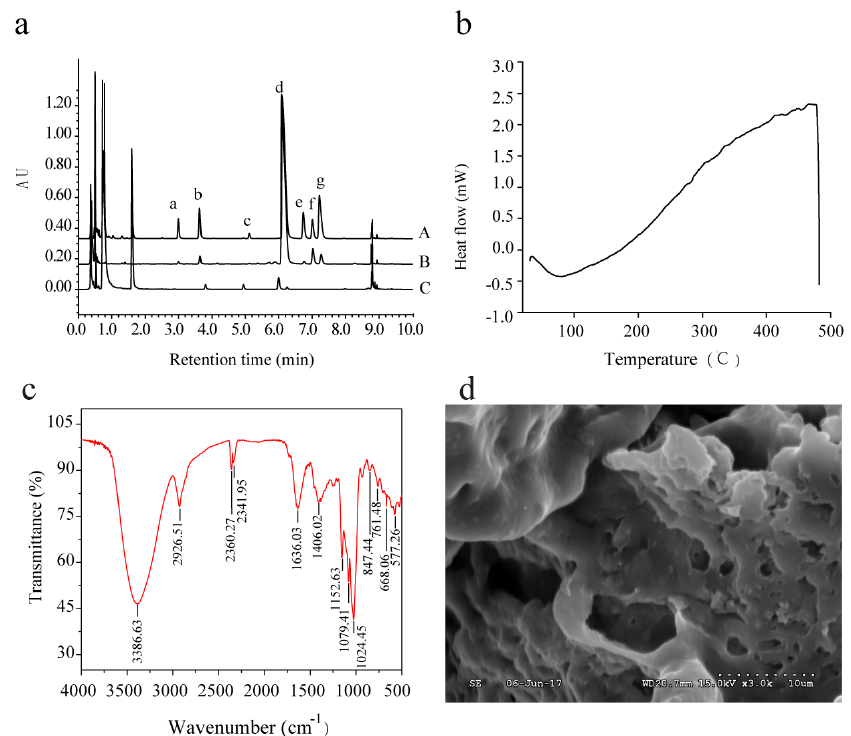
Figure 3. ( a ) Chromatograms of monosaccharide standards and samples (A: monosaccharide standards; B: hydrolyzed RMPs; C: unhydrolyzed RMPs; a: mannose; b: rhamnose; c: glucuronic acid; d: glucose; e; xylose; f: galactose; and g: arabinose); ( b ) DSC thermogram of RMPs; ( c ) FT-IR spectra of RMPs; ( d ) SEM photograph of RMPs (3000 × ). Table 3. Chromatography information and contents of monosaccharide.